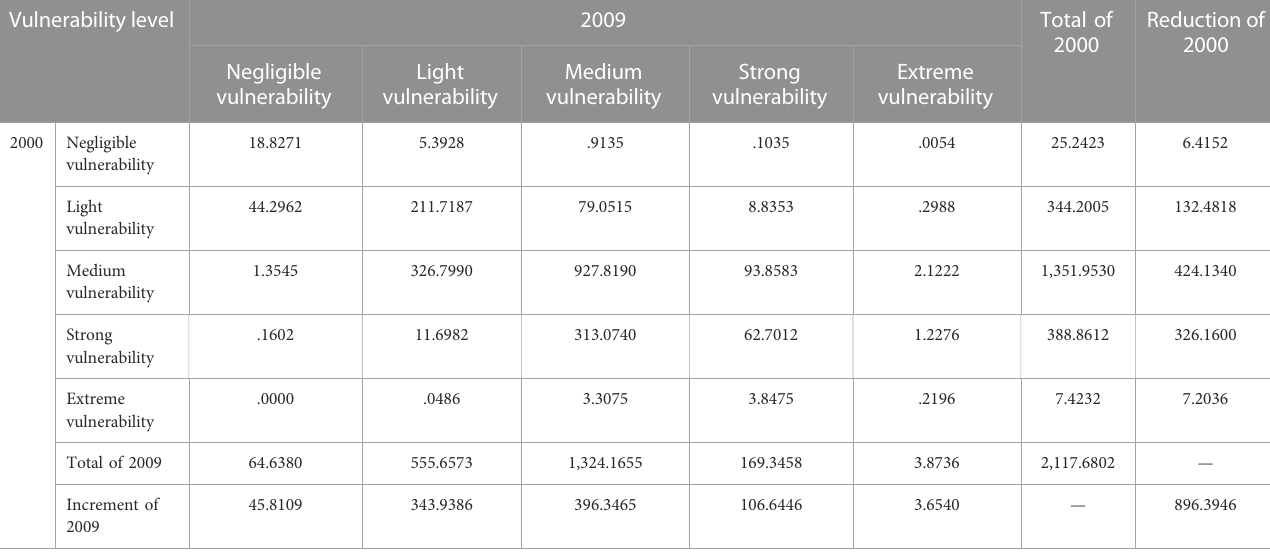
TABLE 5 Area transfer matrix of different ecological vulnerability levels in Zhongxian County from 2002 to 2009 (km 2 ). Vulnerability level 2009 Total of Reduction of 2000 2000 Negligible Light Medium Strong Extreme vulnerability vulnerability vulnerability vulnerability vulnerability 2000 Negligible 18.8271 5.3928 vulnerability